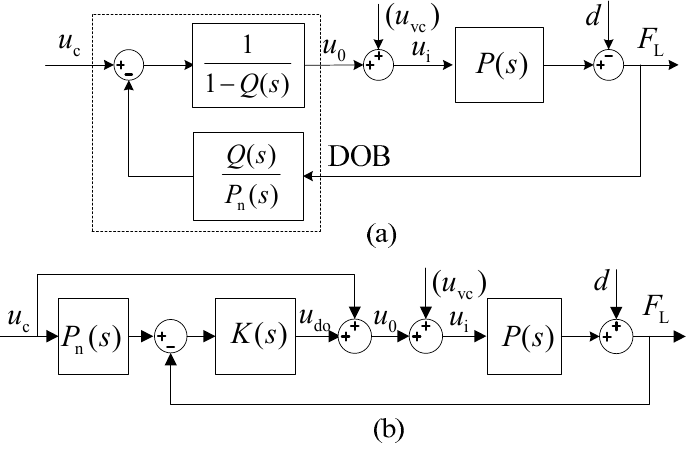
Figure 10. Equivalent structure of DOB: ( a ) from diagram transformation; ( b ) by definition.